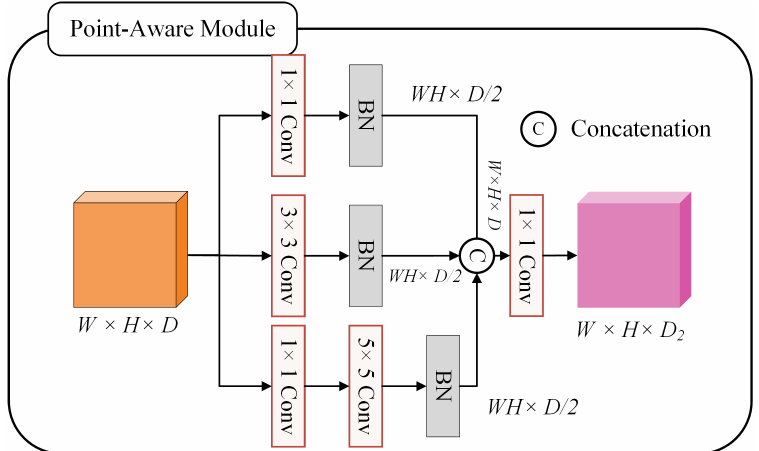
Figure 4. The point-aware module. BN means batch